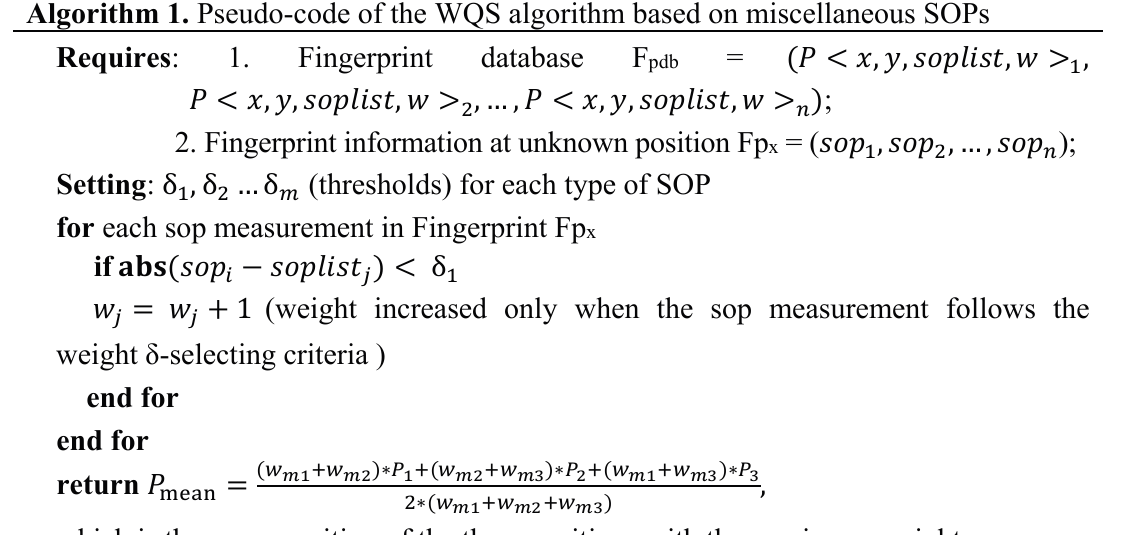
Algorithm 1. Pseudo-code of the WQS algorithm based on miscellaneous SOPs